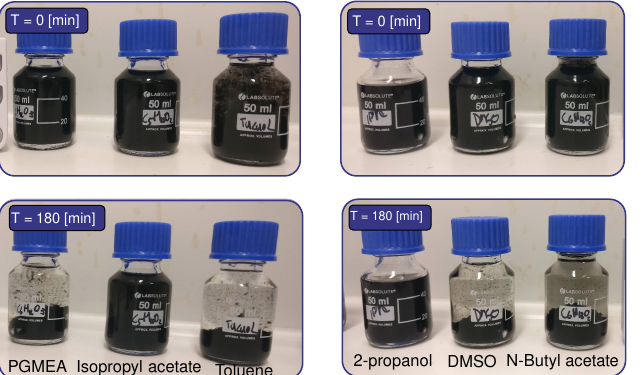
Figure 2. Solvents mixed with multi-walled carbon nanotubes. From left to right: PGMEA, Isopropyl acetate, Toluene, 2-Propanol, DMSO and N-Butyl